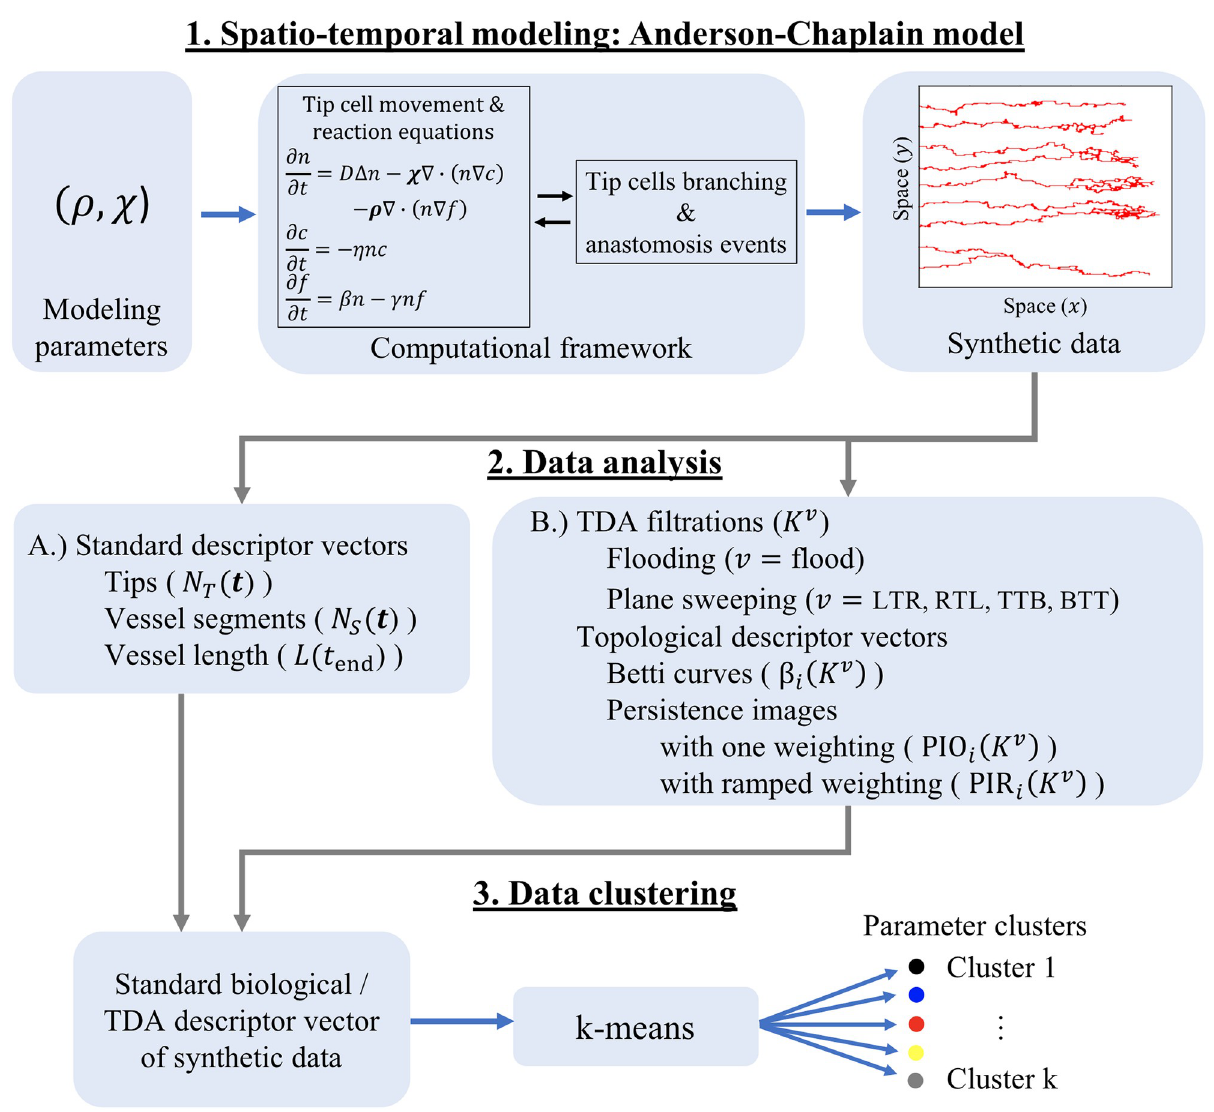
Fig 2. Data generation and analysis pipeline. (1) Spatio-temporal modeling: Anderson-Chaplain model. The Anderson-Chaplain model is simulated for 11 × 11 = 121 different values of the haptotaxis and chemotaxis parameters, ( ρ , χ ). The model output is saved as a binary image, where pixels labeled 1 or 0 denote the presence or absence, respectively, of blood vessels. We generate 10 realizations for each of the 121 parameter combinations, leading to 1,210 images of simulated vessel networks. (2) Data analysis. We use the binary images from Step 1 to generate standard and topological descriptor vectors A.) Standard descriptor vectors We compute the number of active tip cells and the number of vessel segments at discrete time points. We also compute the length of the vessels at the final time point [32, 34, 35, 52]. B.) Topological descriptor vectors. We construct flooding and sweeping plane filtrations [44] using binary images from the final timepoint of each simulation. We track the birth and death of topological features (connected components and loops) that are summarized as Betti curves and persistence images [52]. (3) Data clustering. We perform k -means clustering using either the standard or topological descriptor vectors computed during step 2 from all 1,210 simulations. In this way, we decompose ( ρ , χ ) parameter space into regions that group vessel networks with similar